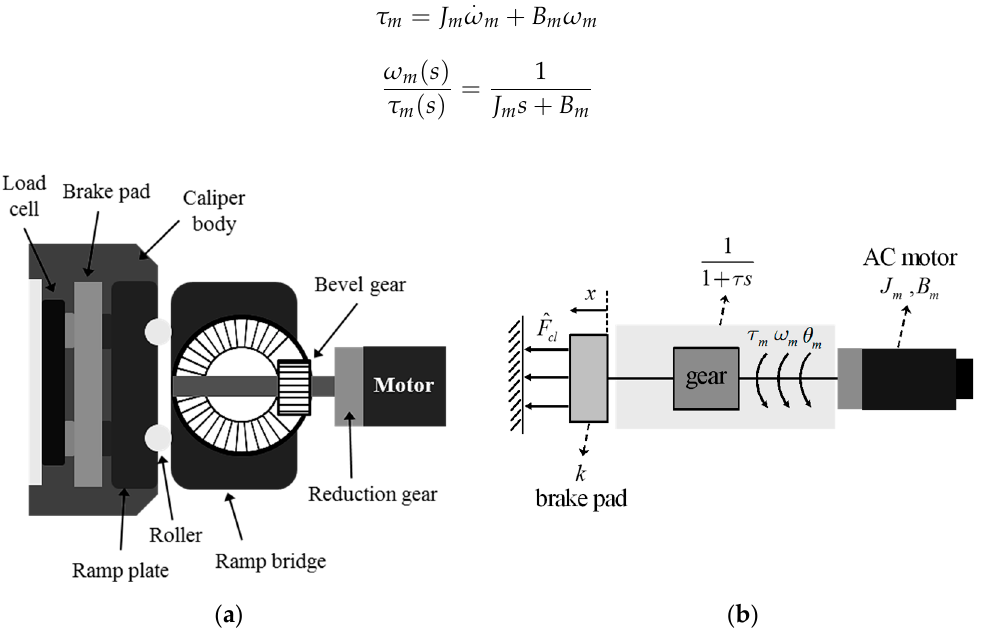
Figure 2. A proposed EMB system: ( a ) EMB schematics; ( b ) Free body diagram of an EMB system.